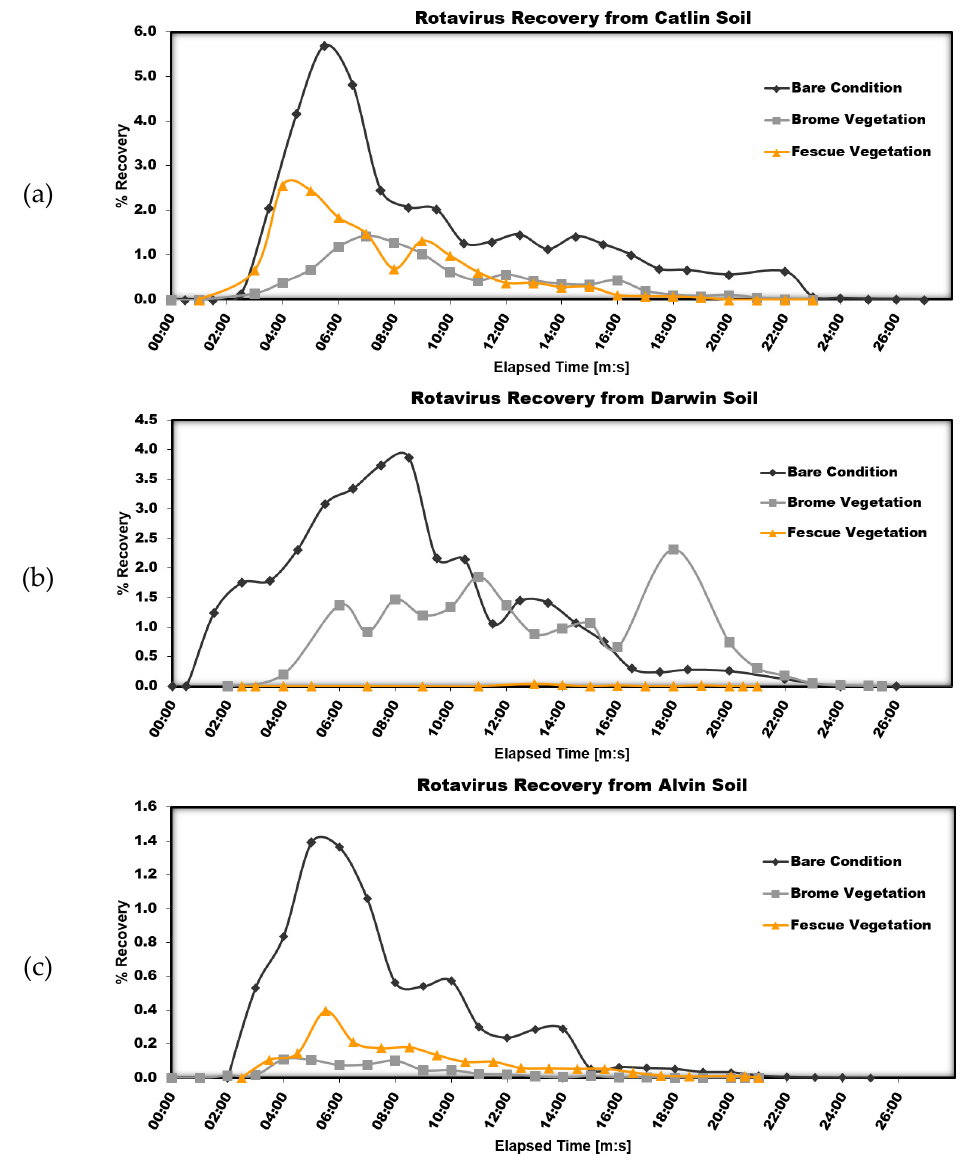
Figure 5. The recovery of infective rotavirus particles from surface runoff is plotted for all three surface conditions according to soil type to compare the effect of vegetation. ( a ) Catlin soil; ( b ) Darwin soil; ( c ) Alvin soil.